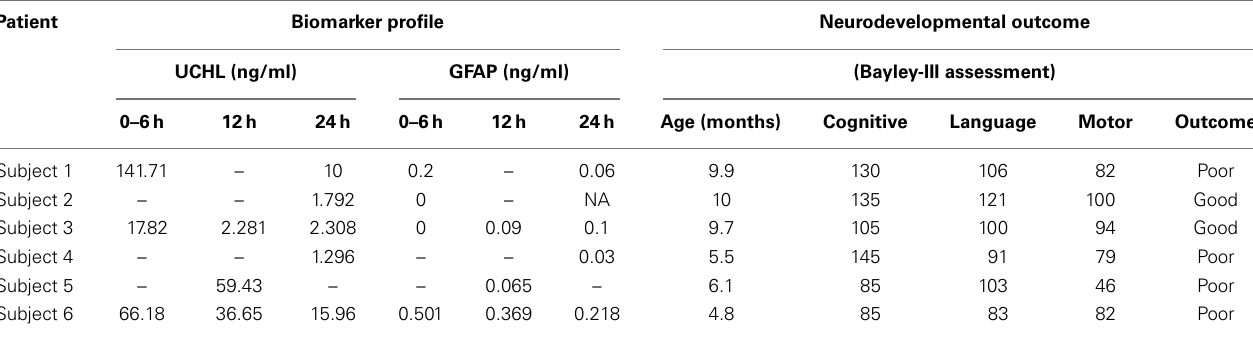
Table 2 | Demographic and key medical variables in a prospective sample of HIE neonates treated with hypothermia who had serial biomarker samples obtained and formal developmental follow-up